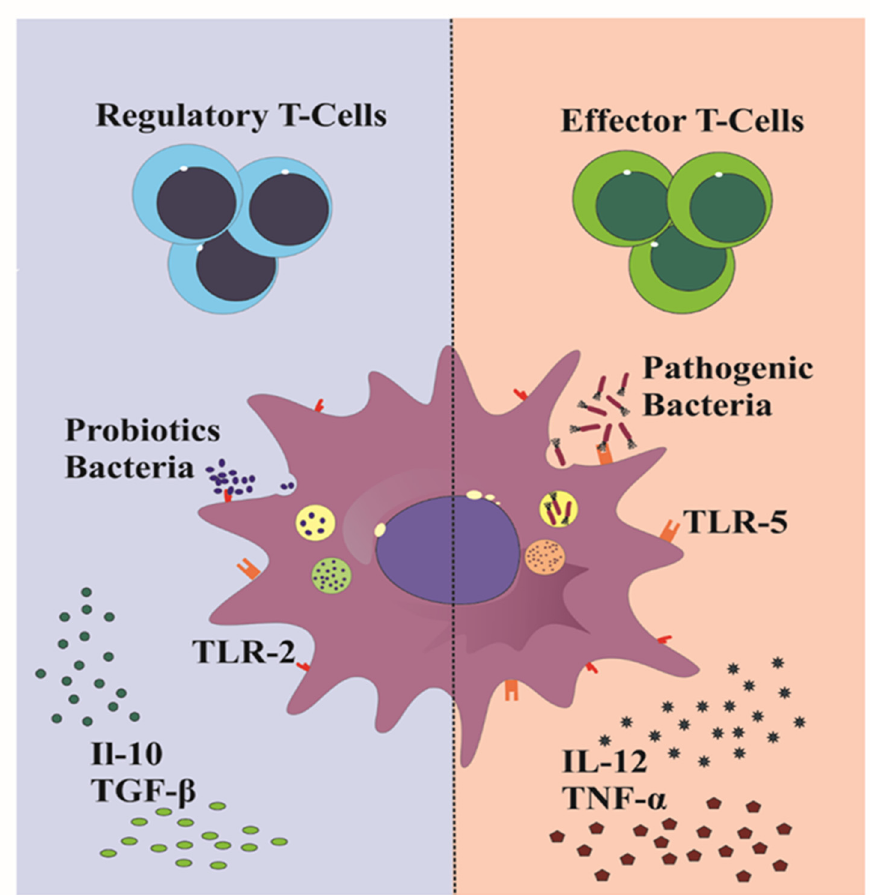
Figure 2. The maturation pathway of dendritic cells. The dendritic cell (middle) drives the develop- ment of effector T cells or T-regs. The response against the microbiota-derived antigens regulates the phenotypic expression of costimulatory (CD80/CD86) molecules through Toll-like receptor (TLR) ligands and specific cytokine release from dendritic cells. Tolerogenic dendritic cells might shift the balance to restore self-tolerance and reach long-term remission in autoimmune and immune- mediated diseases.